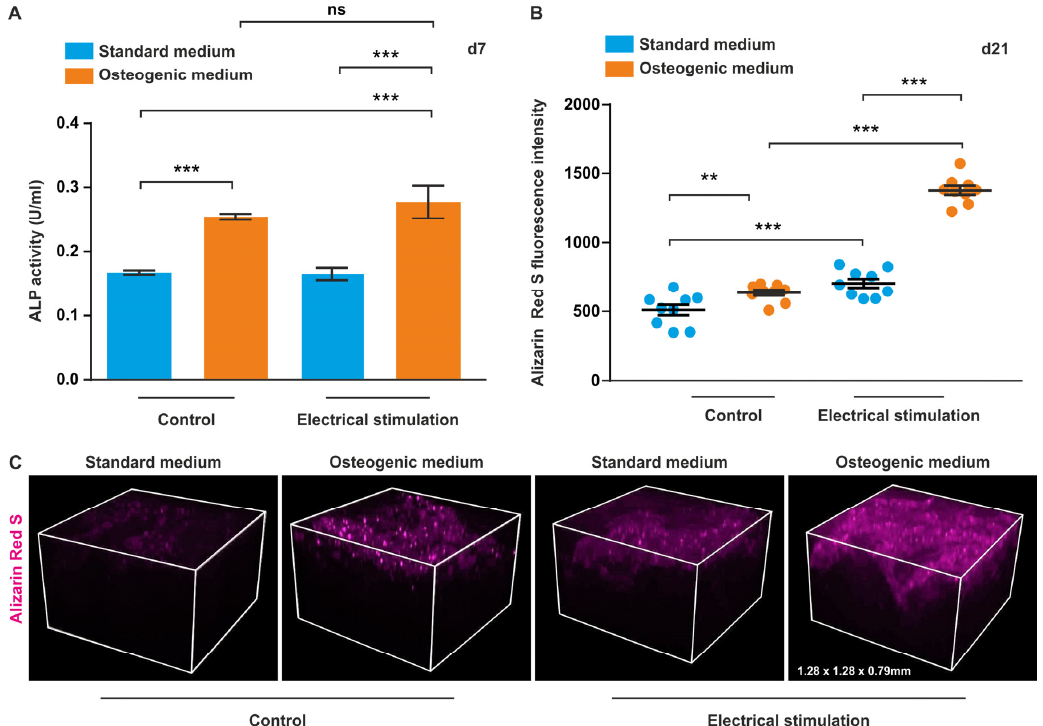
Figure 5. Electrical stimulation (ES) increases alkaline phosphatase (ALP) activity and the level of mineralisation during osteogenic differentiation. ( A ) ALP activity in 3D. ASCs were exposed to ES in osteogenic and standard medium for 7 days followed by an assessment of ALP activity. Significantly higher ALP activities were observed in cells in osteogenic differentiation medium than in standard medium with and without ES. ES resulted in a higher ALP activity in cells in osteogenic medium. ( B , C ). Calcium deposition in 3D. ASCs were cultivated in standard or osteogenic cultivation medium with and without ES. After 21 days, cells were subjected to Alizarin Red S staining and confocal laser scanning microscopy. Osteogenic di ff erentiation conditions led to an increase of mineralisation compared to cells in control medium both with and without ES. ES resulted in significantly higher levels of mineralisation in cells cultivated in osteogenic medium. Error bars: SEM. ** p < 0.01, *** p < 0.0001. Image-based analysis of Alizarin Red S autofluorescence revealed a higher level of mineralisation in cells under osteogenic conditions compared to the controls with and without ES (Figure